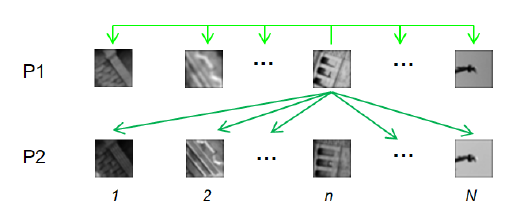
Figure 3. Hardest mining. The patch 𝑝 𝑛 is compared with all the 1 patches with a different 3D index 𝑗 from the patch sets 𝑃 1 and 𝑃 2. The pair with the smallest distance is picked for calculating the loss for unmatched pairs. Arrows: comparison between patches.